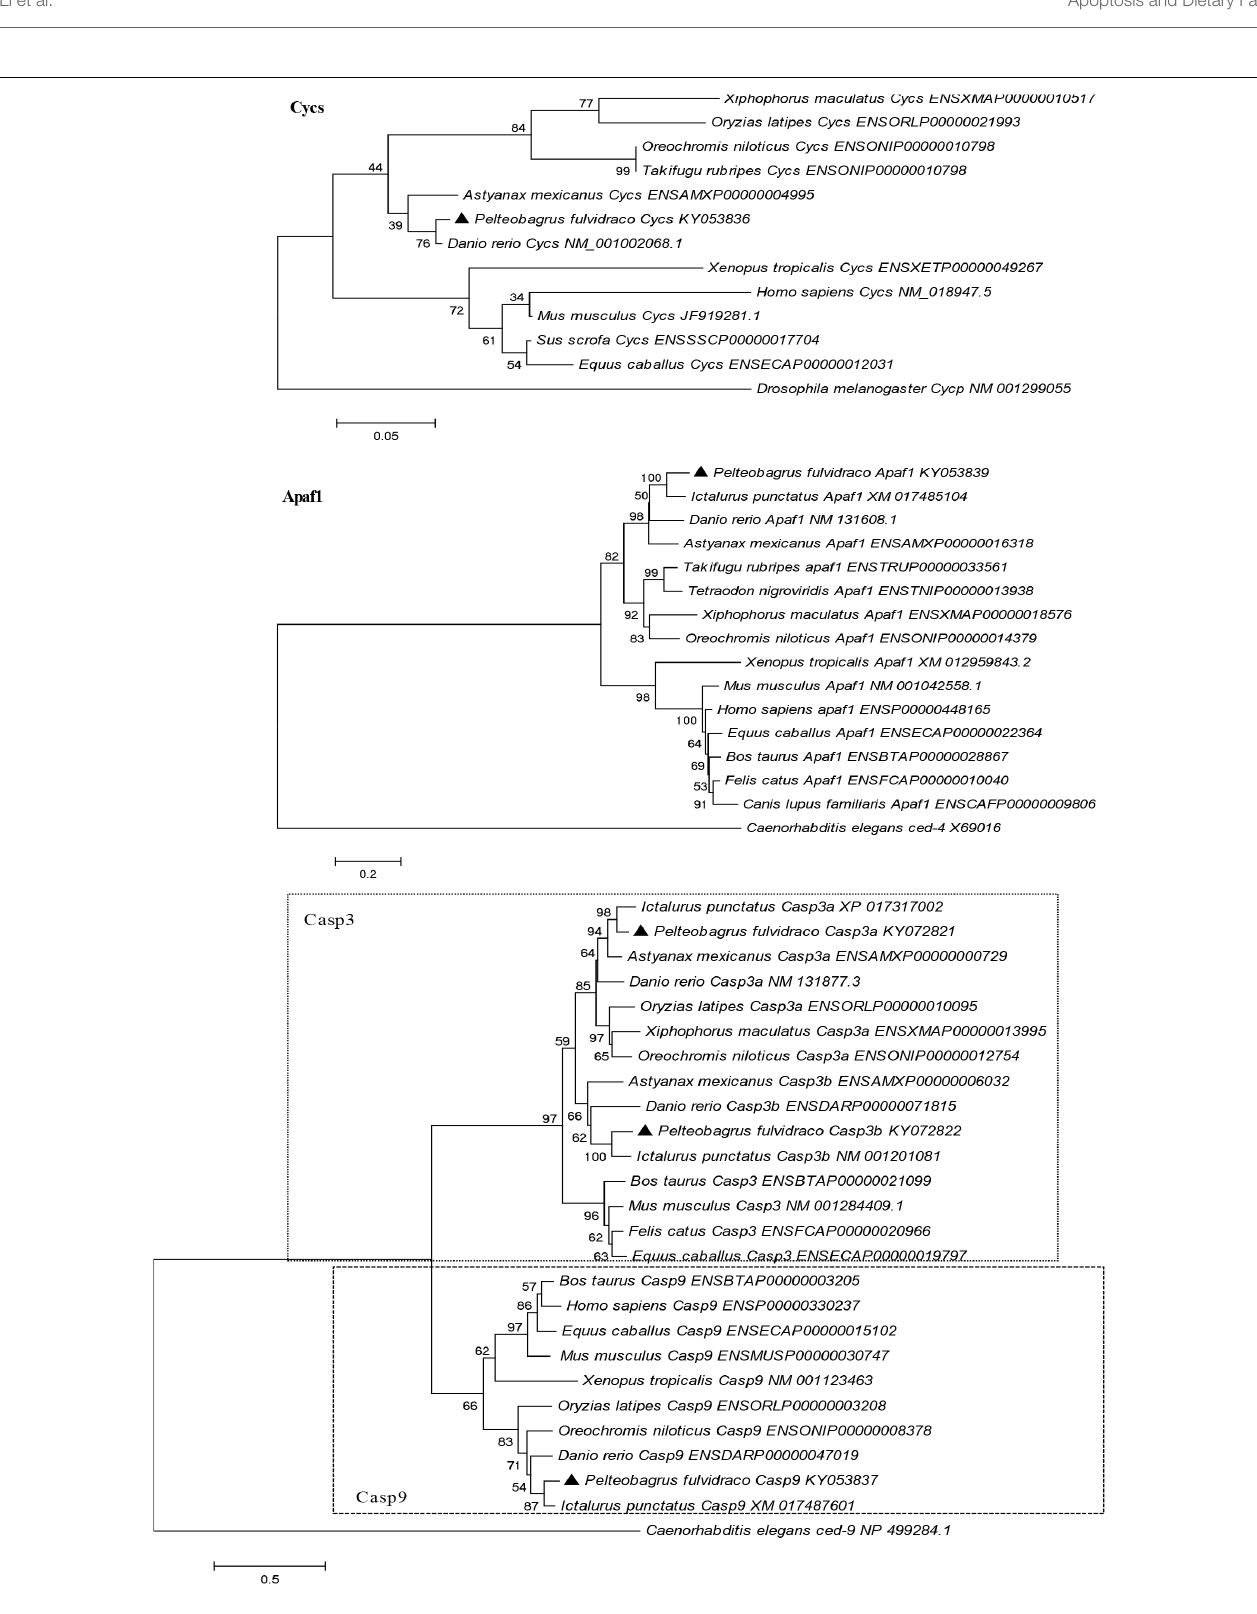
FIGURE 5 | Phylogenetic tree based on the protein sequences of Cycs, Apaf1, Casp3a, Casp3b, and Casp9 from P. fulvidraco and other vertebrate species using the neighbor-joining (NJ) method in MEGA 5.0 (Tamura et al., 2011) based on the JTT+G model (Jones et al., 1992). Branch support values represent a percentage of 1000 bootstrap